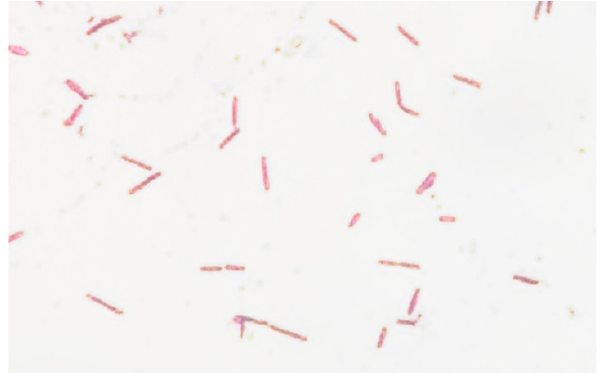
Figure 5. Microscopy of Radiobacter culture. Gram stain, magnification 1000×.